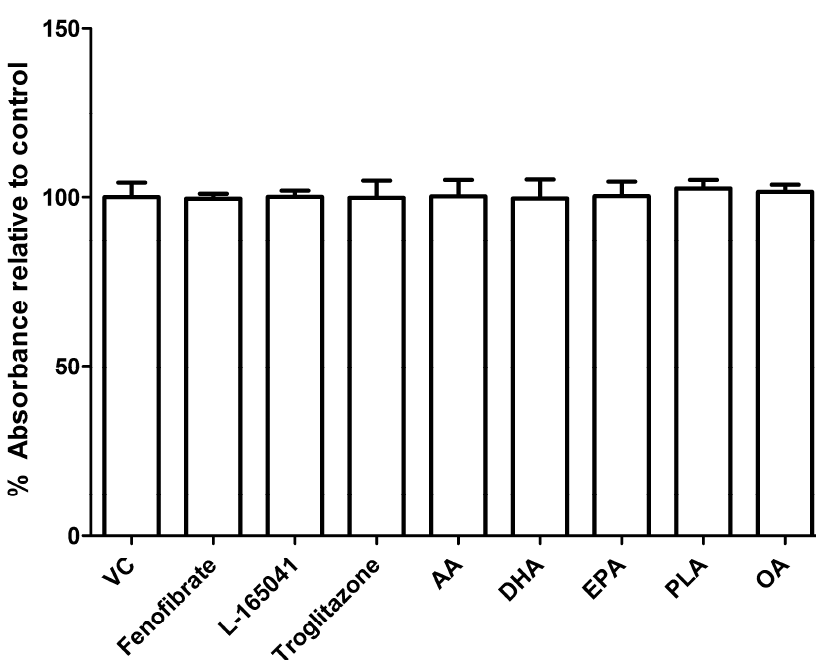
Figure 2. Effect of PPAR agonists and unsaturated fatty acids (UFAs) on cell viability in CD14+ monocytes. CD14+ monocytes were seeded into 96-well and exposed to PPAR agonists or UFAs. Cell viability was determined by resazurin assay. VC: vehicle control.